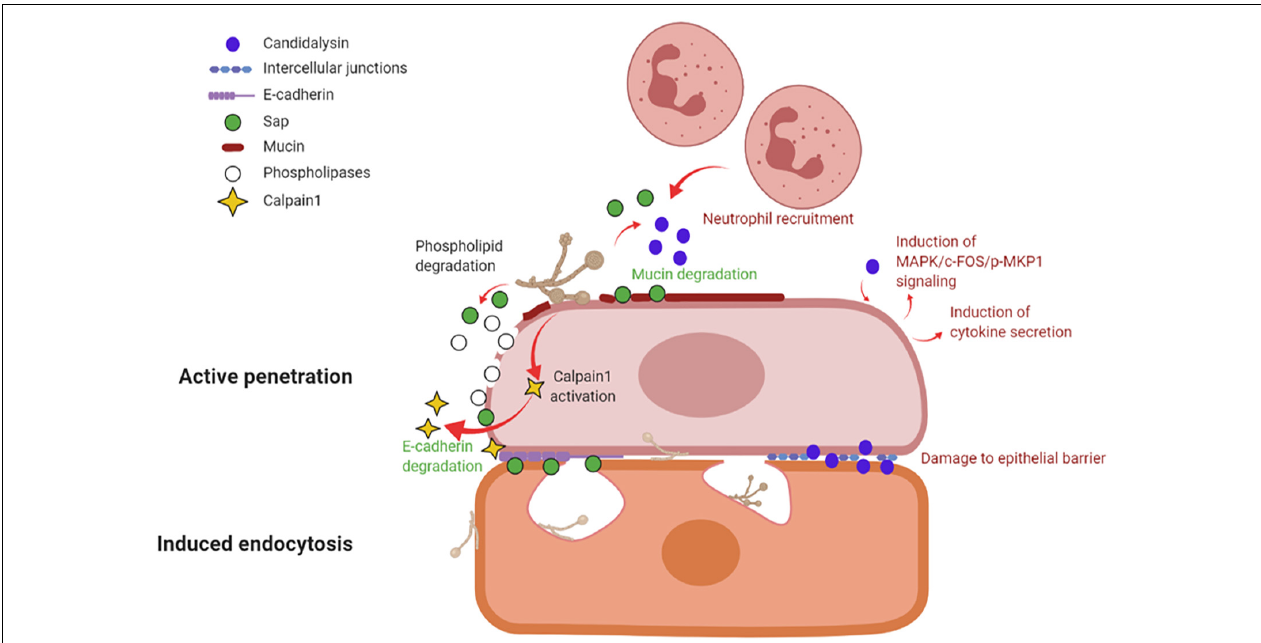
FIGURE 3 | Mechanisms of vaginal epithelial invasion by C. albicans : active penetration and induced endocytosis. By active penetration, C. albicans actively invades the uppermost layers of epithelial cells from where the fungus passes through the intercellular junctions and invades the deeper epithelial layers through either active penetration or induced endocytosis. C. albicans anchors to epithelium via its Als3 adhesin; in addition, the secretion of molecules such as Sap, phospholipases and candidalysin, play a part in fungal invasion. Sap contributes to mucin and intercellular junctions’ degradation, which facilitates fungal invasion, and similarly to candidalysin is responsible for neutrophils recruitment. Candidalysin induces MAPK/c-FOS/pMKP1 signaling and triggers proinflammatory cytokines secretion. The activation of calpain-1 further facilitates C. albicans invasion of deep epithelial layers. The second mechanism of epithelial invasion, induced endocytosis, is mediated by epithelial cells. It begins with the adhesion of C. albicans’ Als3 to the epithelial surface and it is followed by pseudopod formation and fungal uptake inside the cell (created with